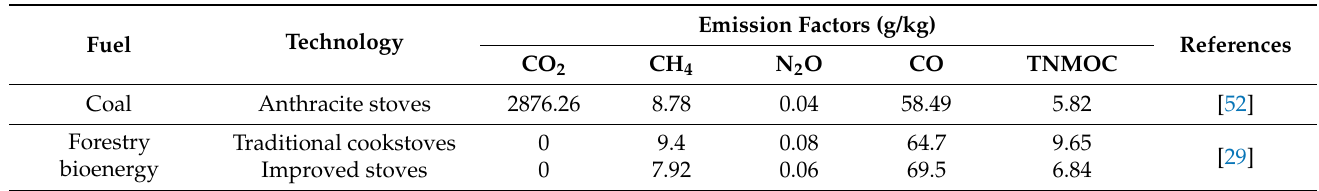
Table 3. Greenhouse gas emission